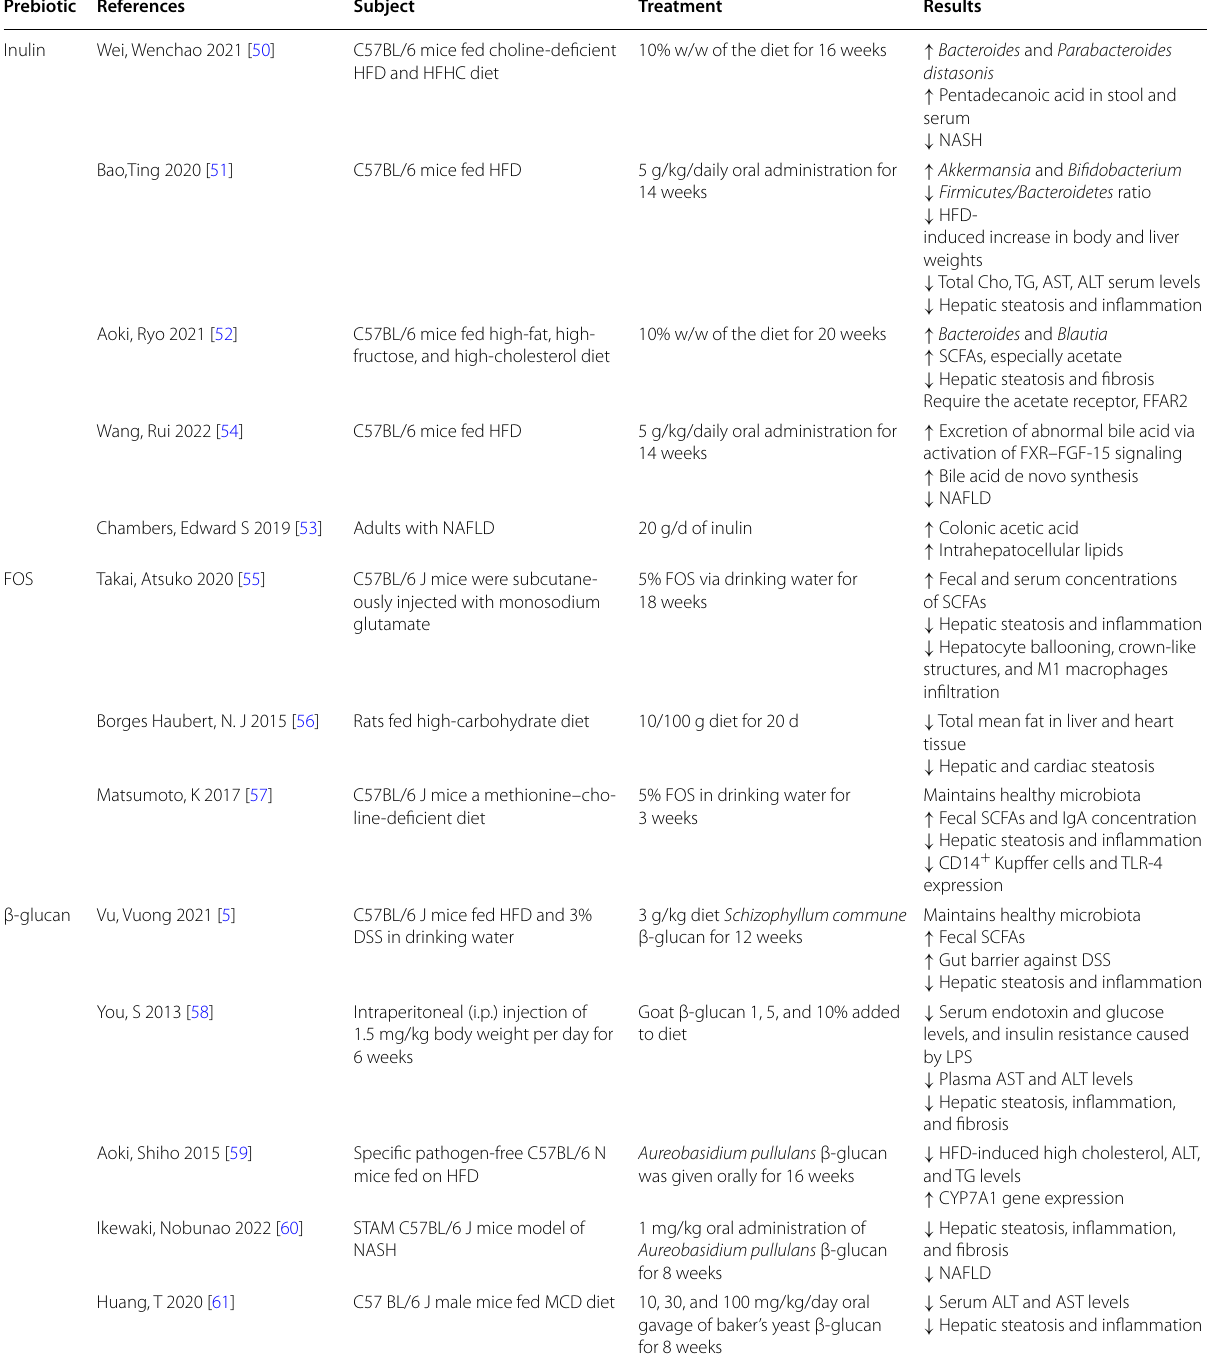
Table 2 Prebiotics-incorporated studies on non-alcoholic fatty liver disease/non-alcoholic